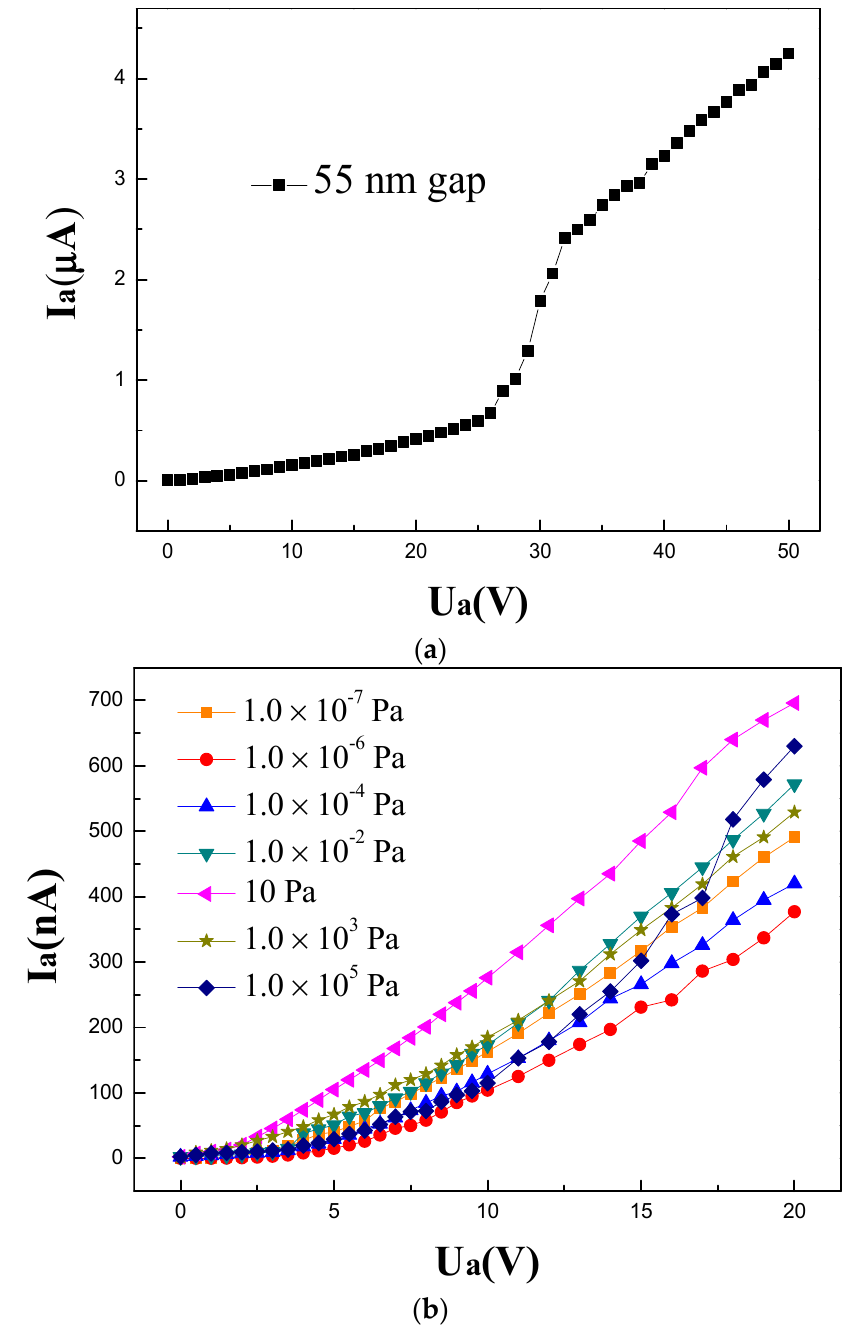
Figure 5. ( a ) Current − voltage plot of the device with a transmission distance of 55 nm. ( b ) Field emission characteristics under different vacuum degrees. emission characteristics under different vacuum